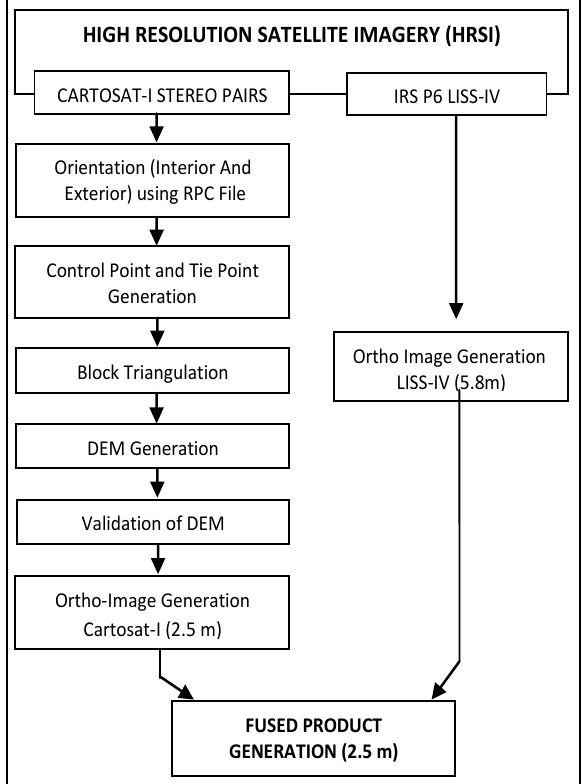
Figure 2: Methodology for generation of fused product